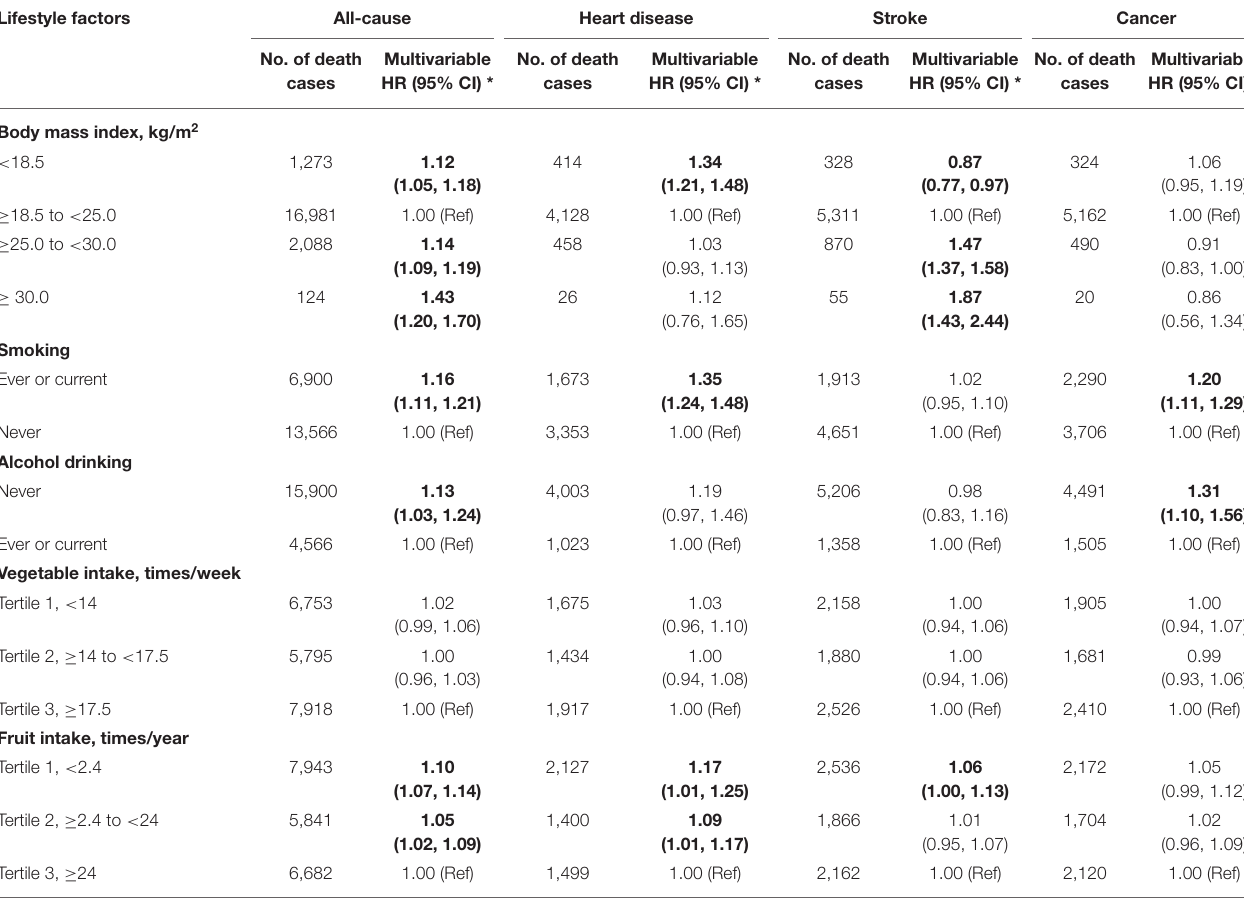
TABLE 2 | Hazard ratios (HRs) and 95% confidence intervals (95% CIs) for the associations between individual lifestyle factors and risk of all-cause and cause-specific